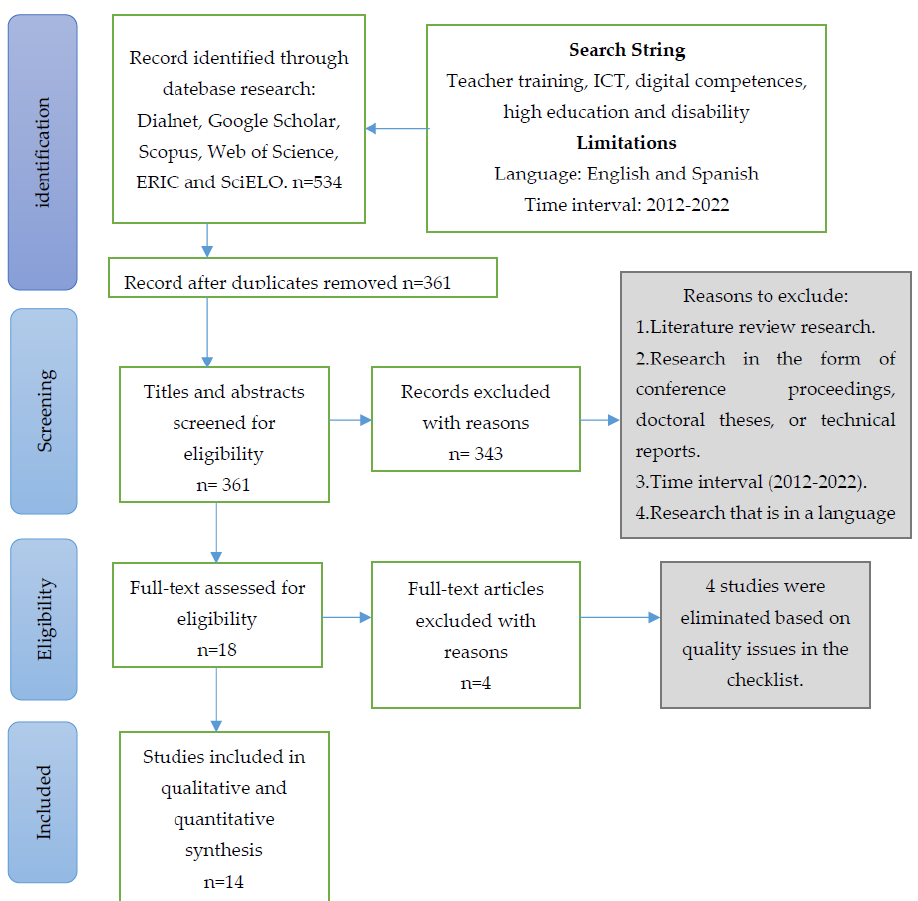
Figure 1. Flow chart of the search, selection, and inclusion of studies.